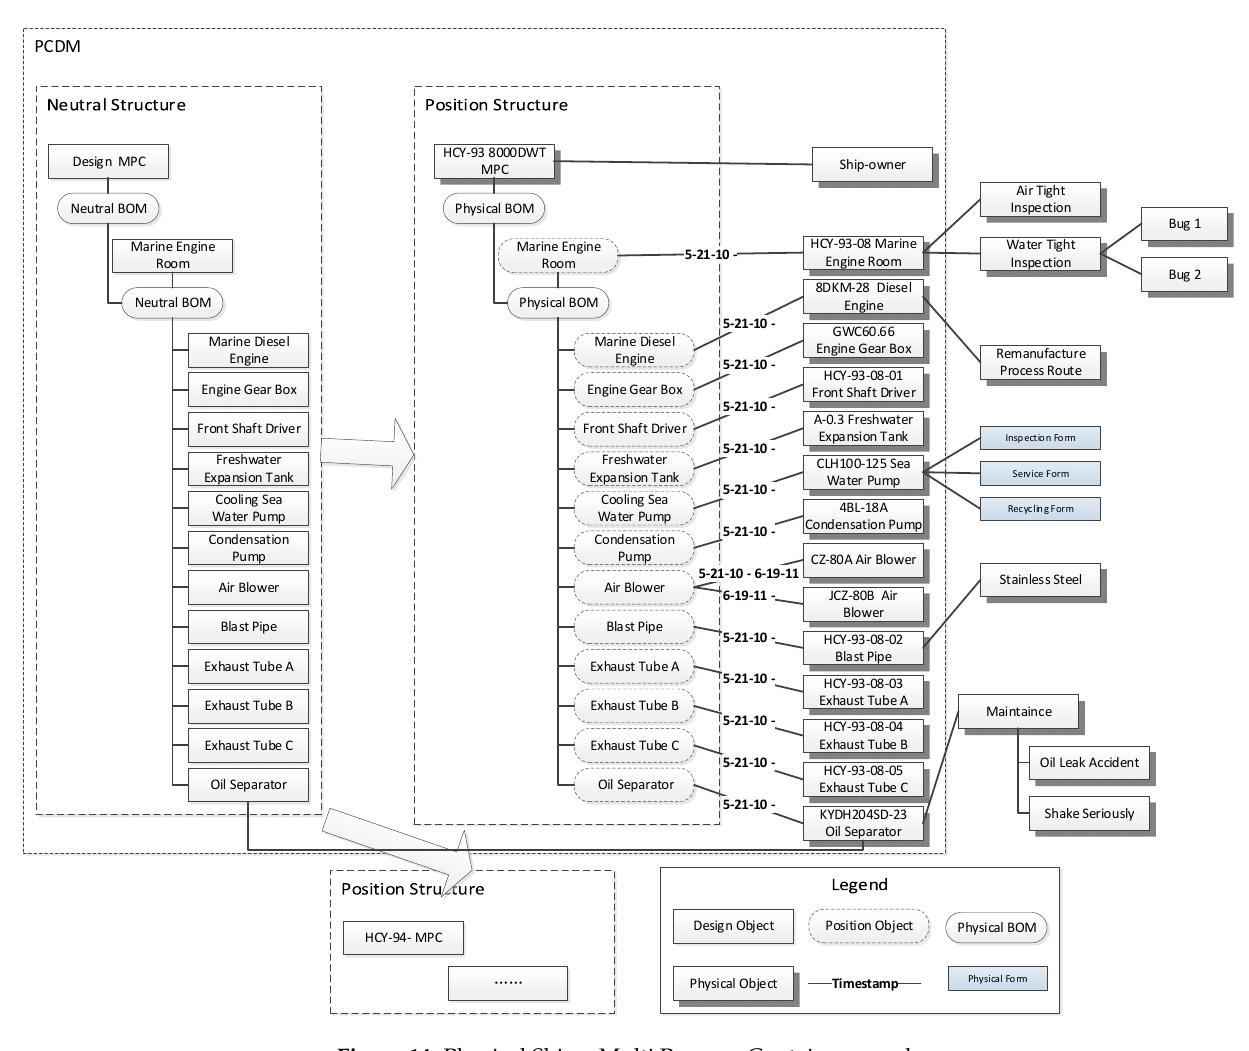
Figure 14. Physical Ship—Multi Purpose Container vessel.